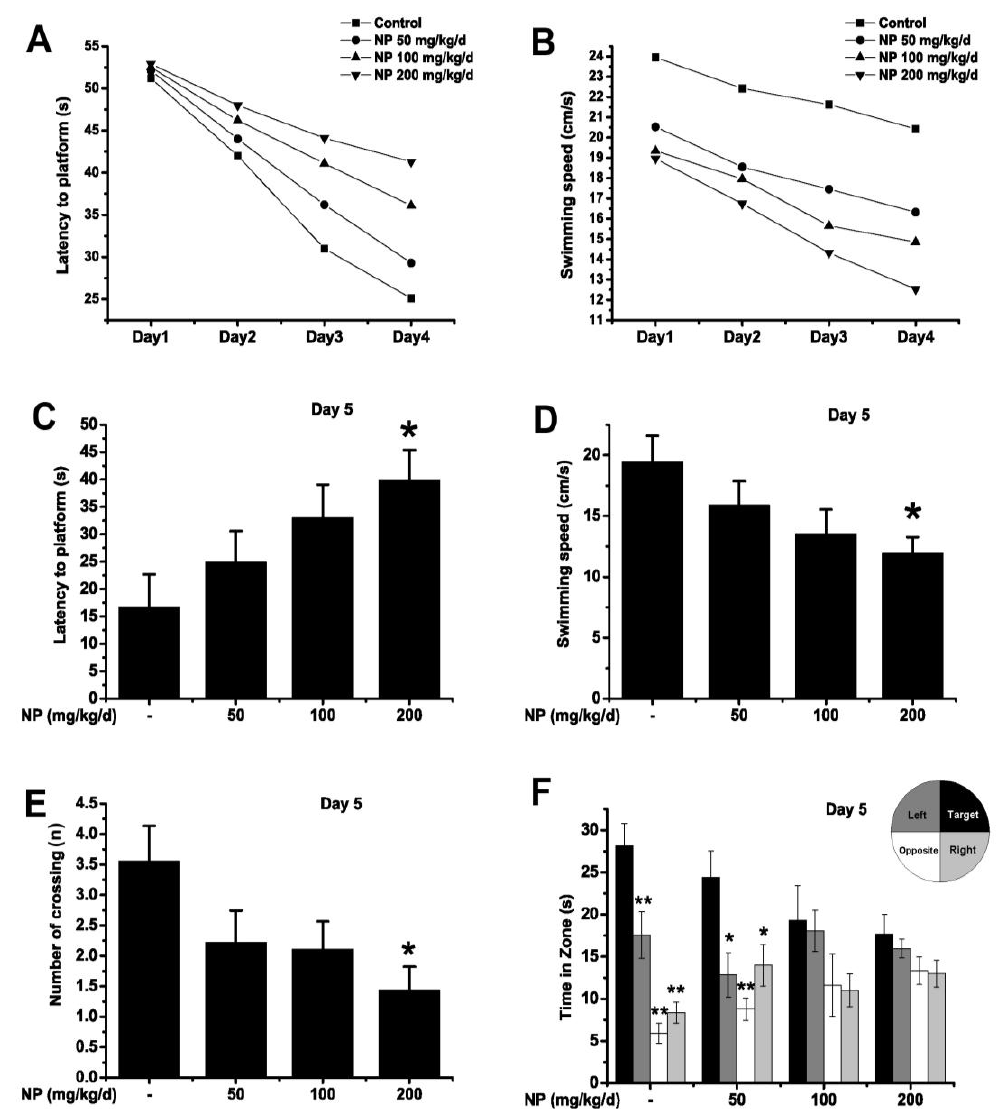
Figure 3. The Morris water maze test of NP treated mice at different doses or vehicle ( n = 9). All values are expressed as means ± S.E.M. ( A ) Comparison of latencies to platform